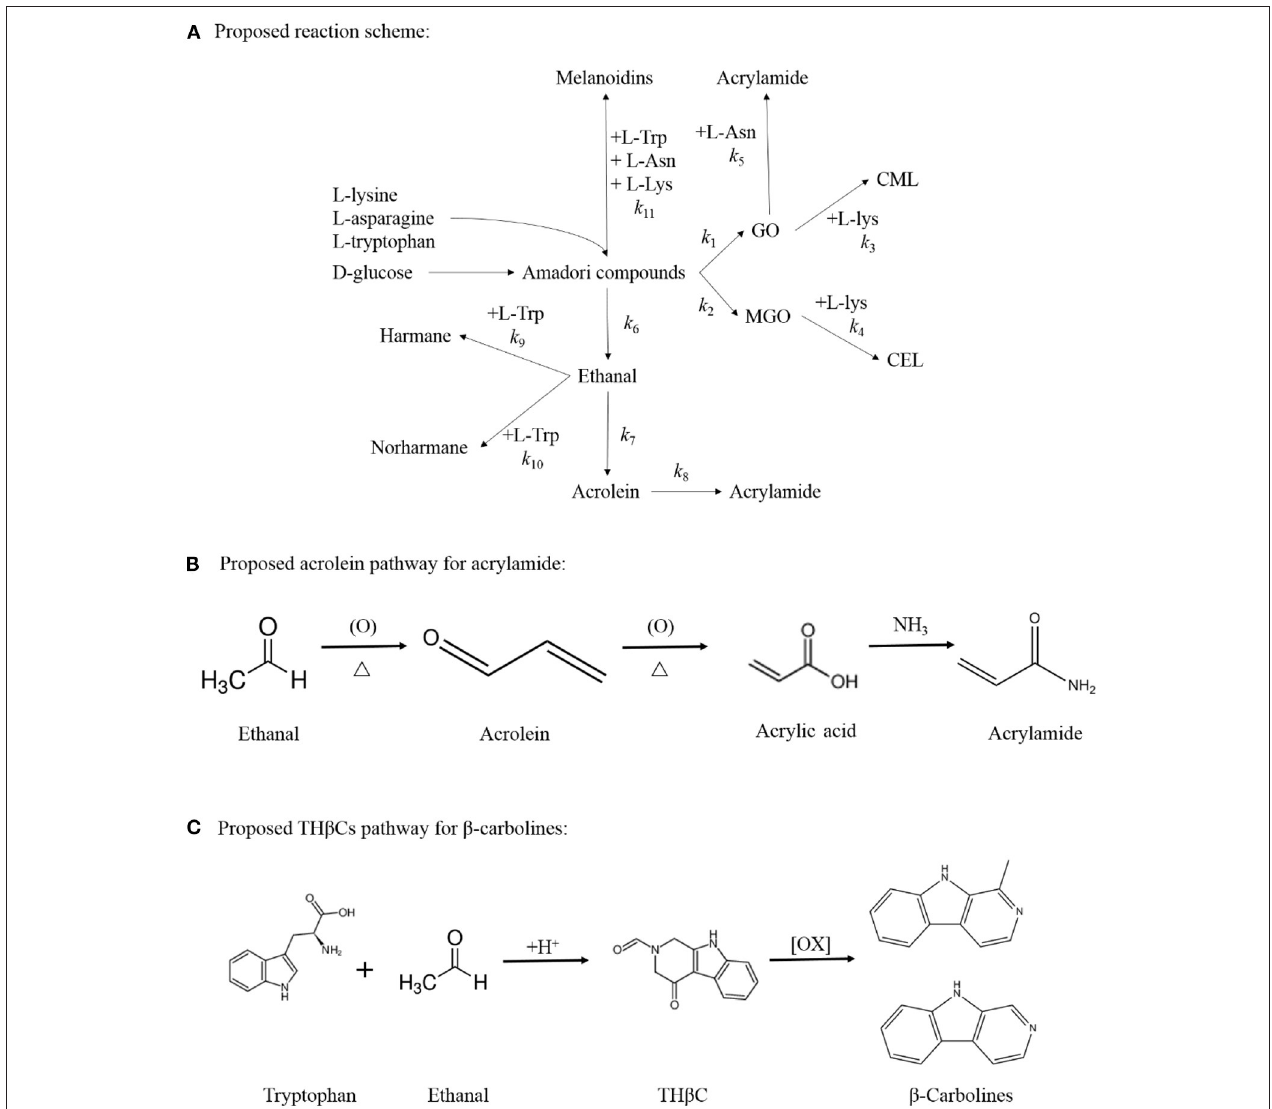
FIGURE 1 | Proposed reaction scheme for the simultaneous formation of acrylamide, CML, CEL, harman and norharman in multiple precursors amino acids/ glucose chemical model system (A) . Proposed acrolein pathway for the production of acrylamide (B) and Proposed TH β C pathway for the generation of β -carbolines (C)